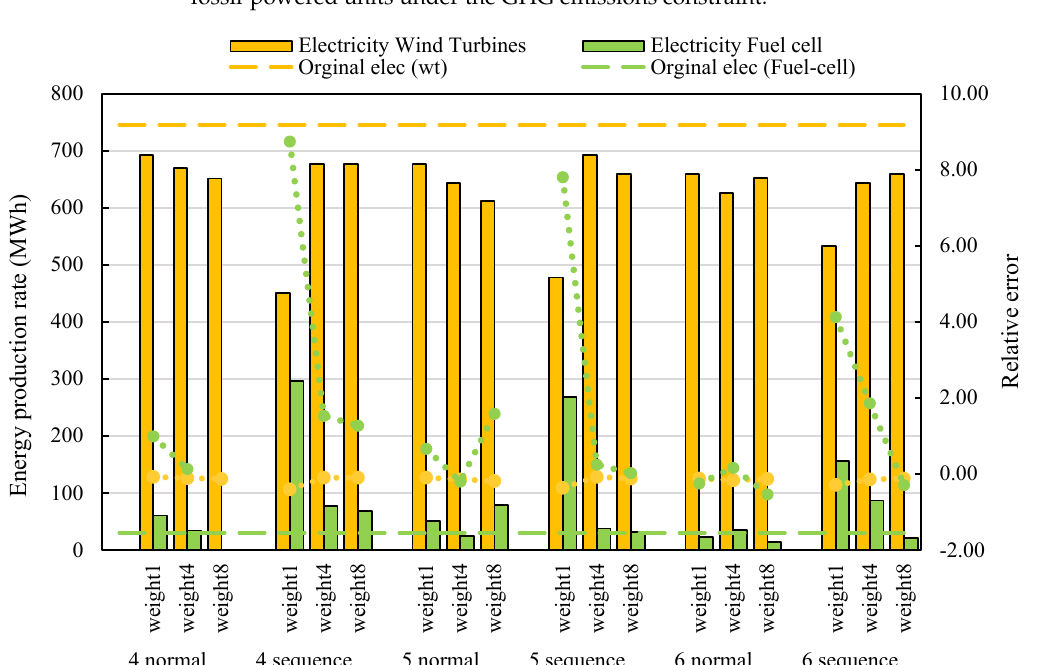
Figure 15. Total utility production by wind turbines and storing units for the clustered and original model under the GHG emissions constraint.